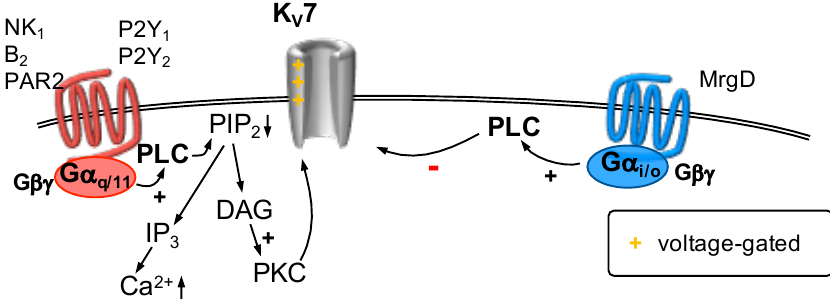
Figure 7. K V 7 channels are activated by depolarizing voltages (as indicated). G α q /11 -coupled receptors ( left ) activate phospholipase C (PLC), which cleaves phosphatitylinositol 4,5, bisphosphate (PIP 2 ) into inositol 1,4,5 trisphosphate (IP 3 ) and diacylglycerol (DAG). Depletion of PIP 2 from the plasma membrane is sufficient to decrease currents through K V 7 channels. In addition, Ca 2 + is released from the endoplasmic reticulum subsequent to formation of IP 3 . Ca 2 + decreases K V 7 currents via an interaction with calmodulin. Activation of a G α i / o -coupled receptor ( right ) was shown to decrease K V 7 currents in a PLC-dependent